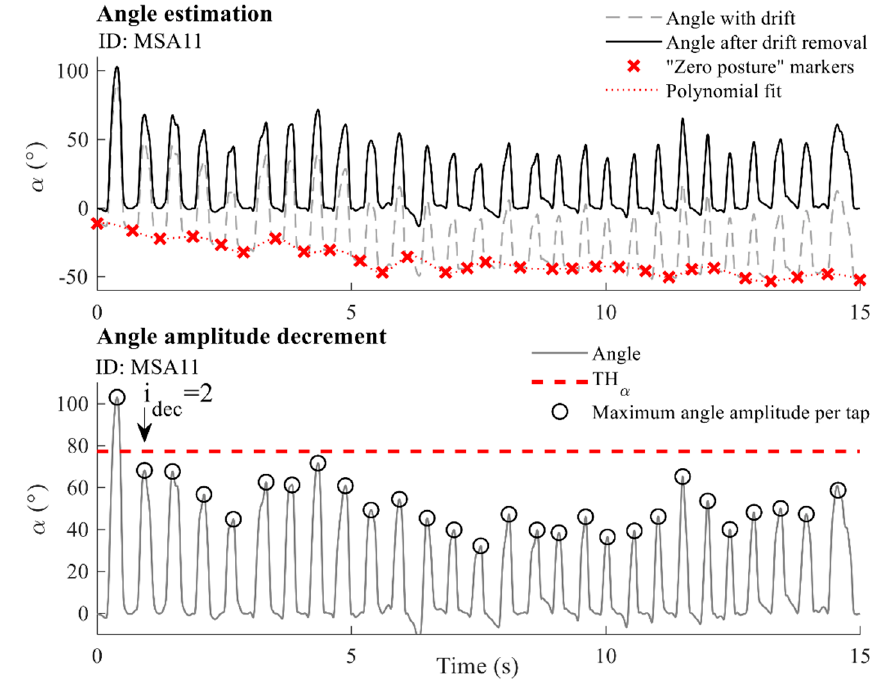
Figure 4. Upper panel: Angle estimation. The dashed grey line marks the drifted angle sequence, and the solid black line corresponds to the angle sequence after drift removal. Red crosses show “zero posture” markers, and the dotted red line presents the polynomial fit used for drift removal. Lower panel: Angle amplitude decrement. The solid grey line shows the angle sequence, whereas black circles mark the angle amplitudes (highest finger apertures) per tap. The dashed red line presents the threshold TH α used for the detection of decreased amplitudes. The example is given for one MSA patient (ID: MSA11).